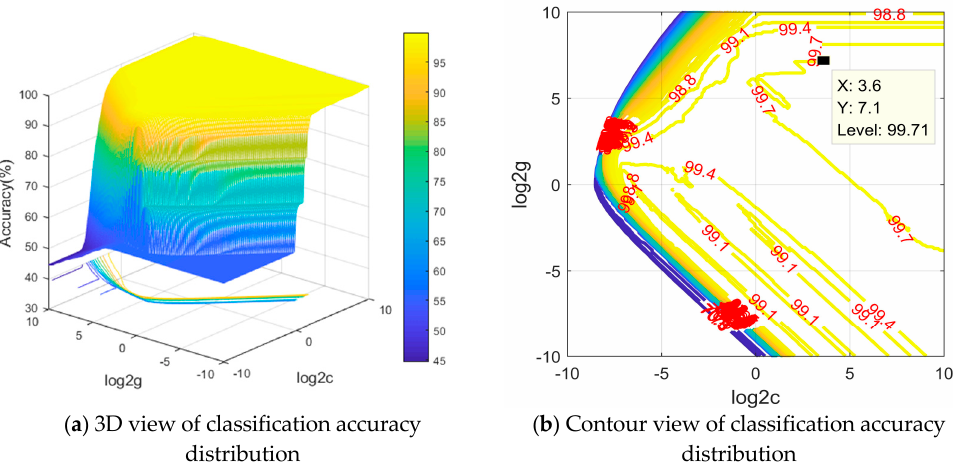
Figure 12. The distribution of the classification accuracy at different parameters (3D view and contour view).